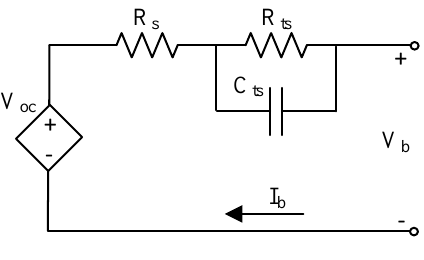
Figure 3. Thevenin battery